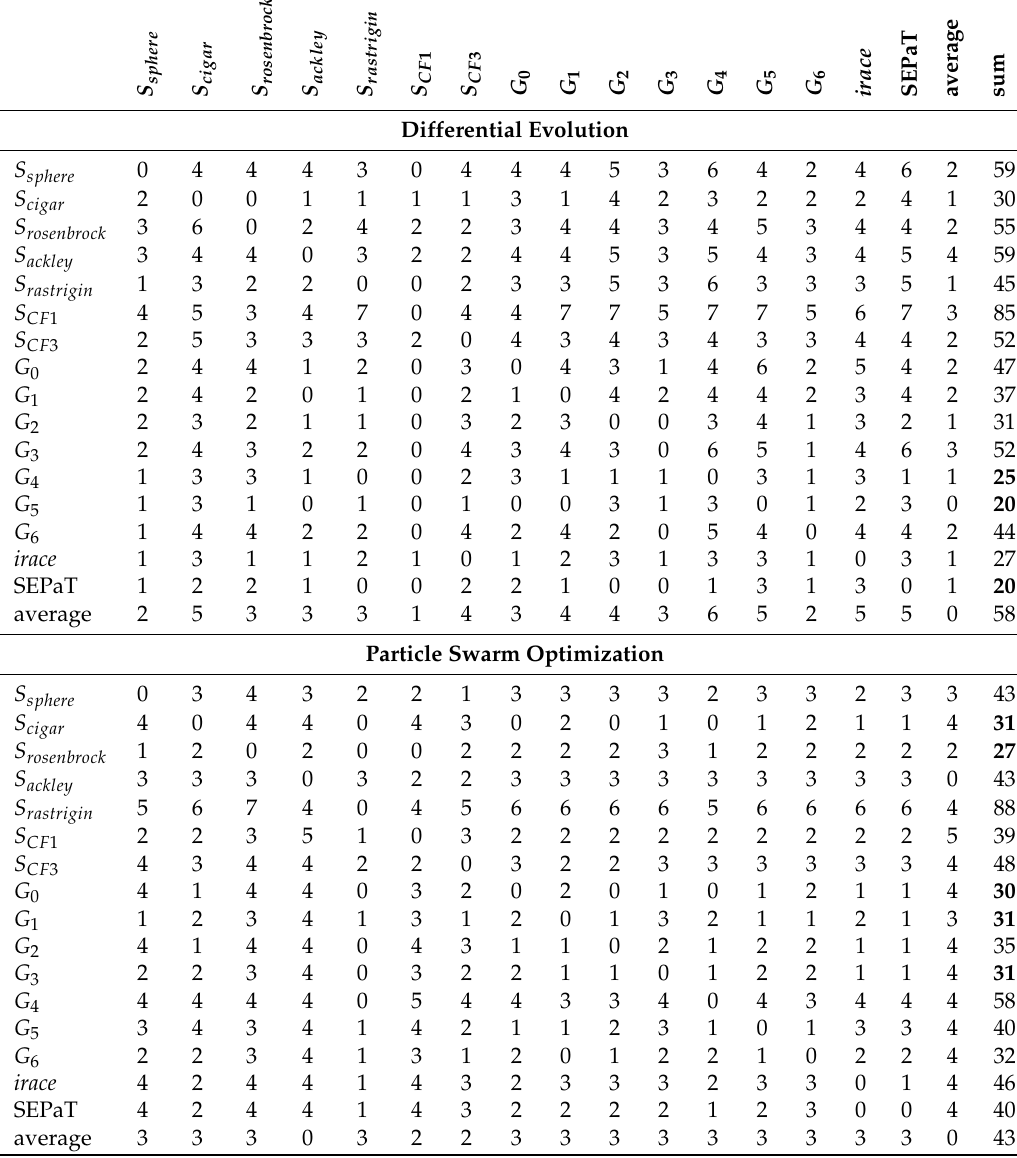
Table 10. Number of test functions for which the optimizer associated with the row is statistically worse than the one associated with the column. The last column reports the sum of the values in that row, measuring the optimizer performance (the lower, the better). The three best configurations are highlighted in